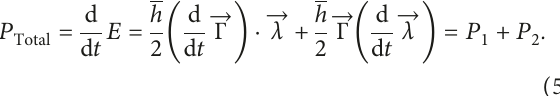
Figure 10: Power dissipation comparison between different size (4-, 8-, 16-, and 32-bit) parity generator